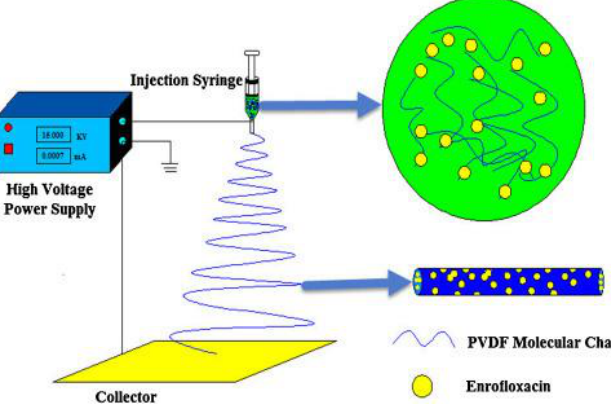
Figure 5. Preparation of drug-loaded PVDF fibres by electrospinning. Reproduced with permission [230].